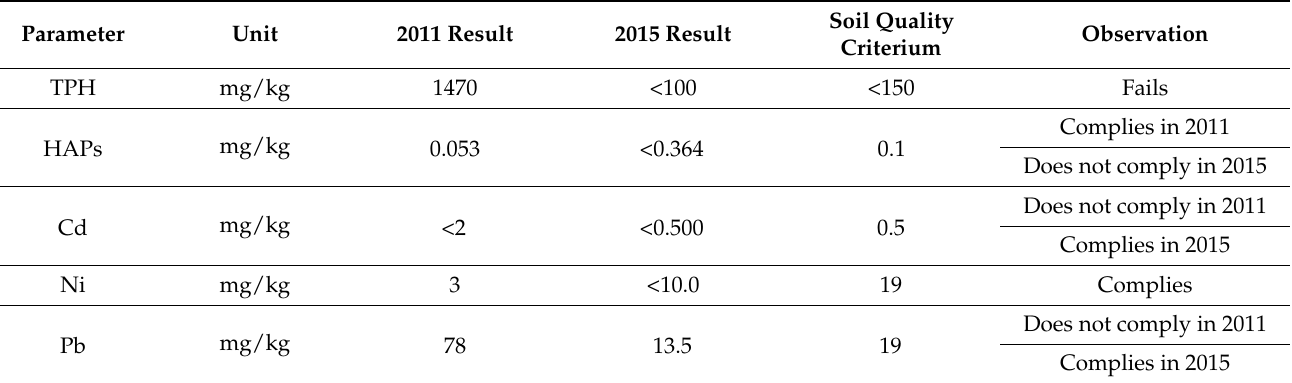
Table 7. Results of the physical-chemical analysis in the Tambococha area. The first results are from EIA and PMA (code B1), the second from ACT. EIA and PMA (code B1), and soil quality criteria are from AM 097 -A (Table 1) [103], based on the Environmental Impact Study 2011 [104] and Update on the Environmental Impact Study Project Development and Production of the Tiputini and Tambococha Fields 2015 [105].